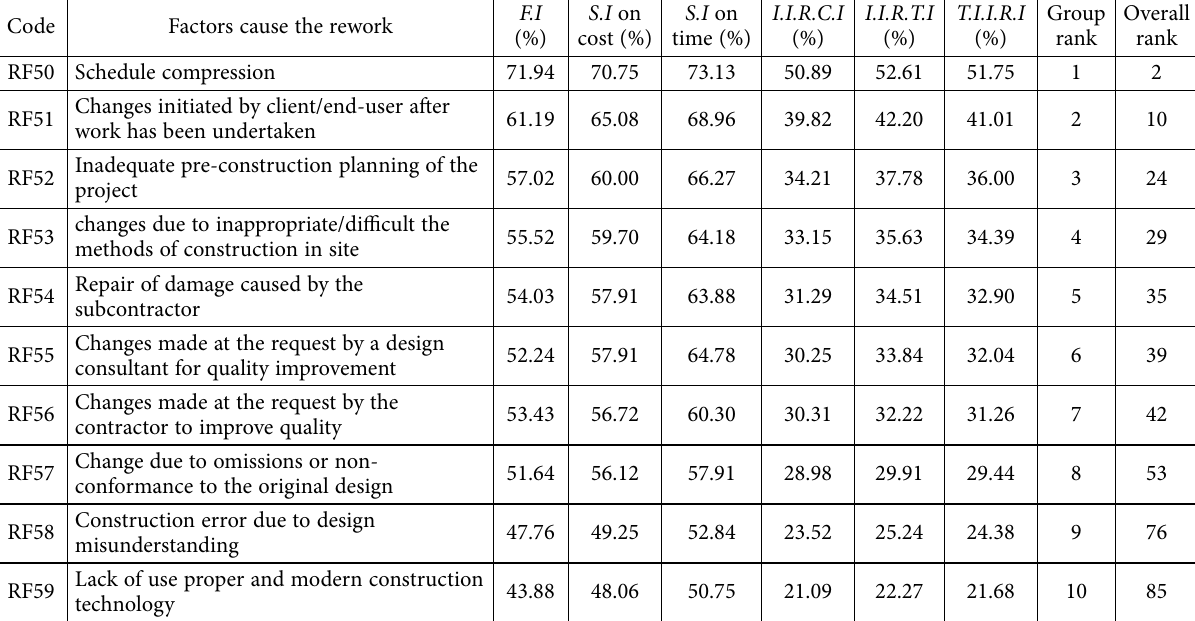
Table 9. Ranking the causes and impact of rework factors related to the construction group